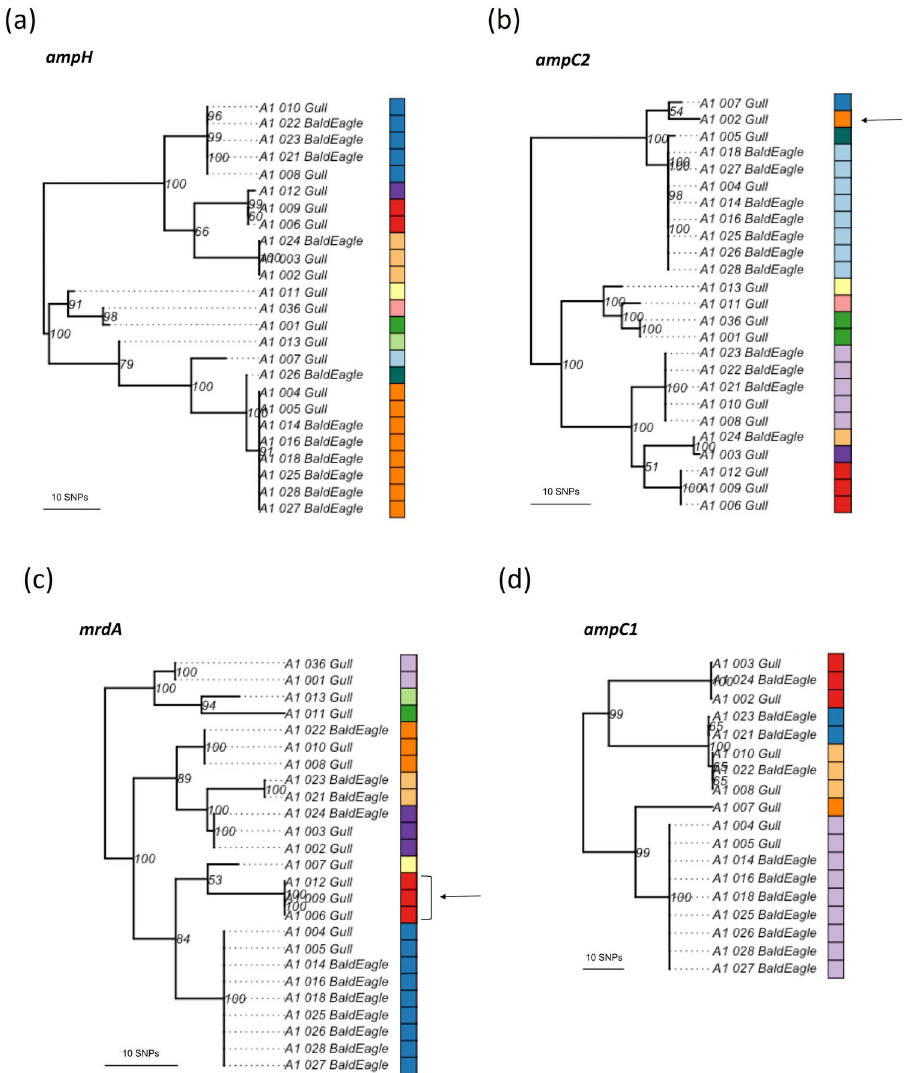
Figure 3. Midpoint rooted maximum likelihood phylogenies of cephalosporin-resistant E . coli isolates originating from gulls and bald eagles in Alaska based on individual chromosomally-encoded AMR genes – ( a ) ampH , ( b ) ampC2 , ( c ) mrdA , and ( d ) ampC1 . Each colour indicates a different allele for each gene sequence. Arrows indicate incongruence with the core genome phylogeny. Branch support values are indicated and based on 100 bootstrap